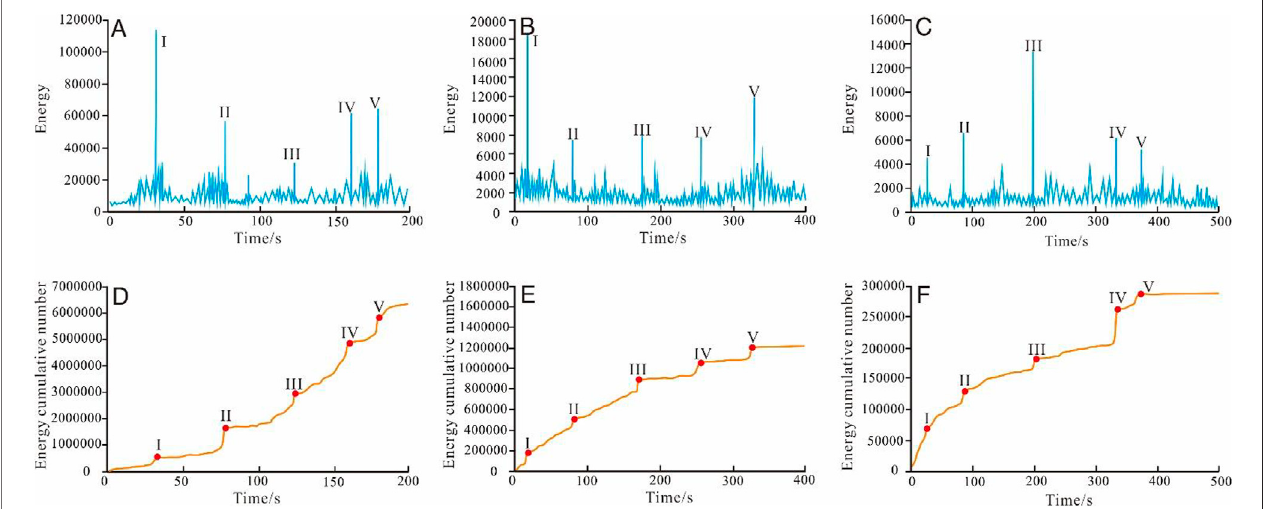
FIGURE9| Acousticemission experimental resultsoftheWellL203H79-4(3842.81 – 3843.16 m). (A) , (D) .Thesamplingangle is0 ° ; (B) , (E) .Thesamplingangleis 45 ° ; (C) , (F) . The sampling angle is 90 ° .